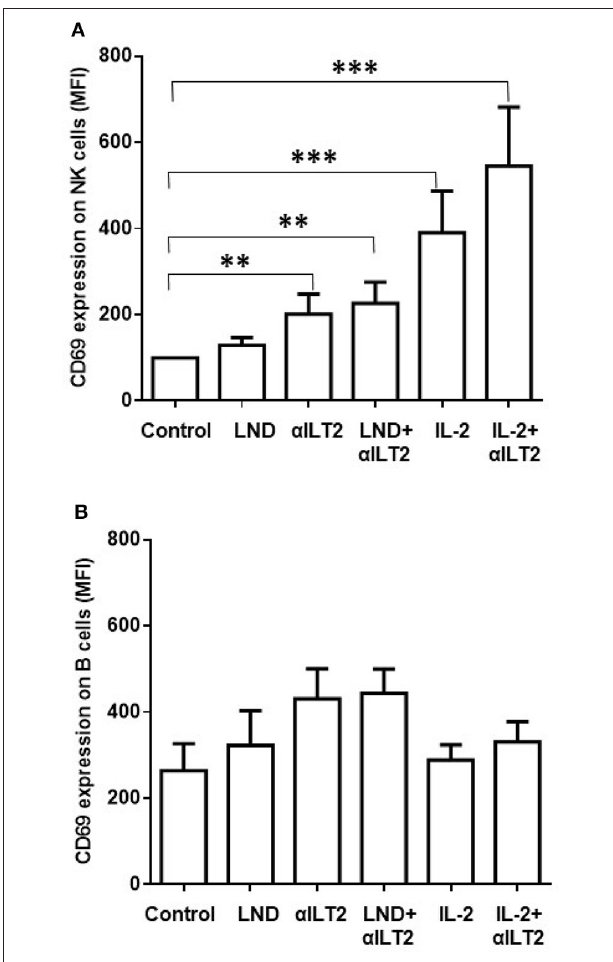
FIGURE 5 | Effect of ILT2 blockade and lenalidomide on the activation of NK cells in CLL. Flow cytometry analyses were conducted to evaluate NK cell expression of CD69 in PBMCs obtained from 14 CLL patients and stimulated with anti-ILT2 blocking antibody (10 µ g/ml) or irrelevant IgG 1 (10 µ g/ml) and lenalidomide (LND, 1 µ M) or IL-2 (50 U/ml) for 7 days. The figure shows the comparison between the surface expression of CD69 detected on NK cells (A) and leukemic cells (B) . Bars represent the MFI of CD69 ± SEM for each condition. SEM, Standard Error of the Mean; Wilcoxon Matched-Pairs Signed Ranks test; ** P < 0.01, *** P <